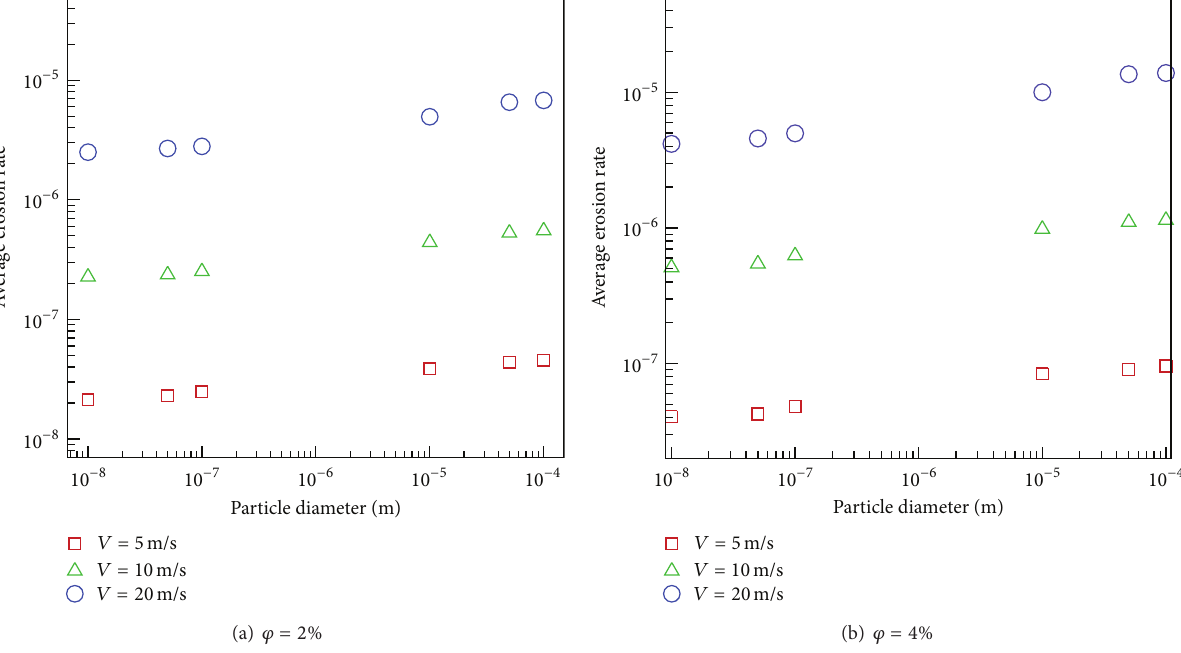
Figure 11: The variation of particle size with average erosion